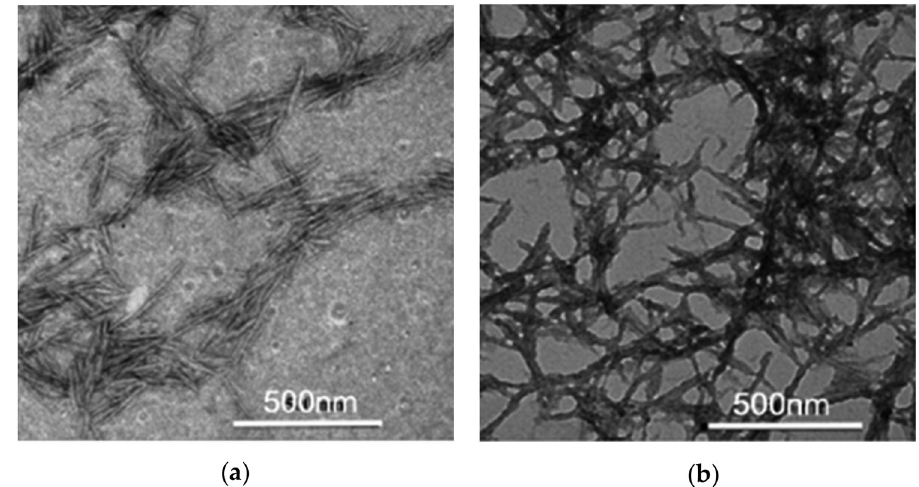
Figure 2: TEM image of ( a ) NC and ( b ) PDA/NC nanocomposite.